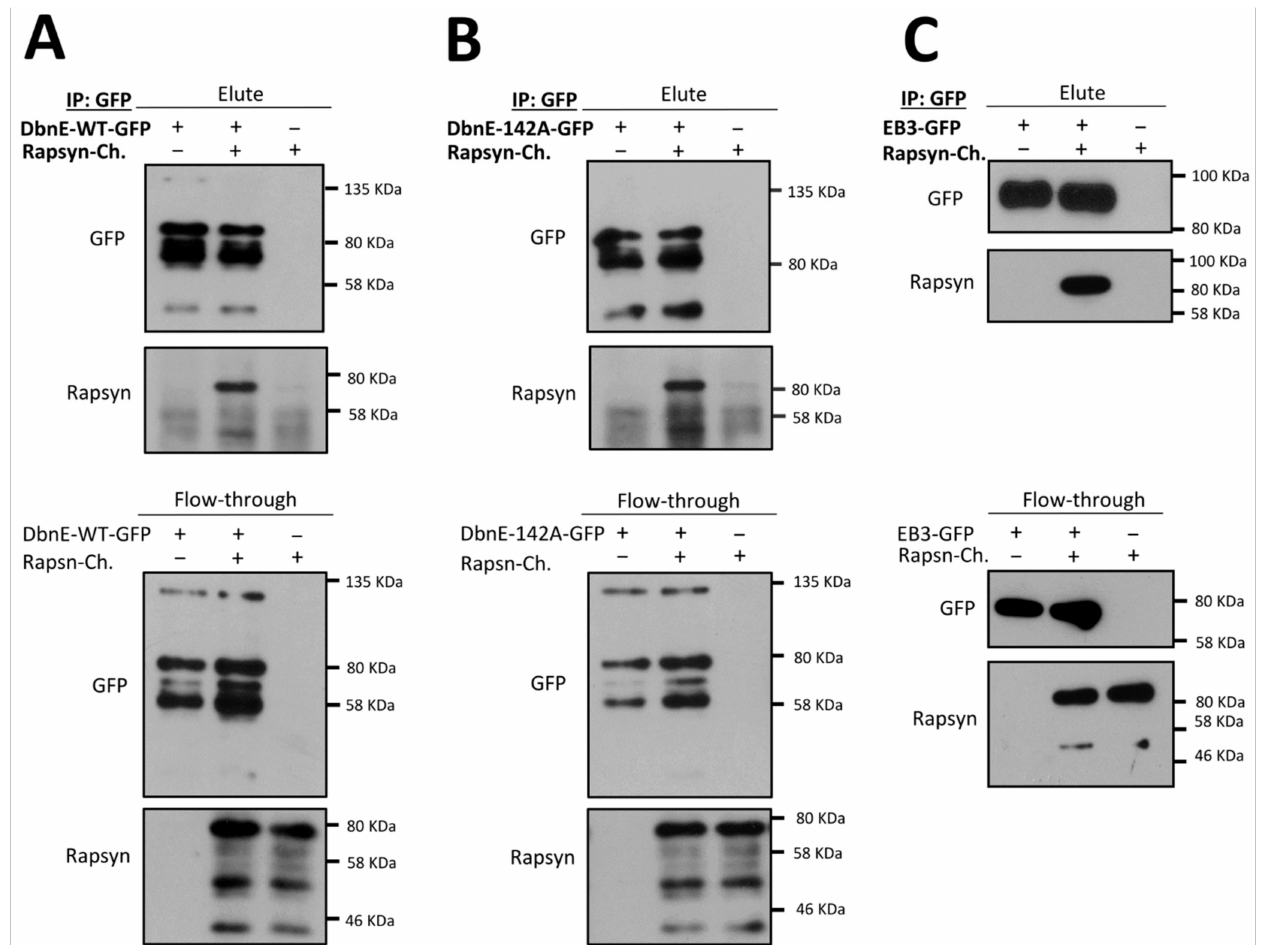
Figure 8. AChR-clustering regulator rapsyn interacts with drebrin. ( A ) Coimmunoprecipitation of overexpressed wild-type drebrin (DbnE-WT-GFP) with rapsyn (Rapsyn-mCherry) in HEK293 cells. ( B ) Coimmunoprecipitation of overexpressed phospho-dead drebrin mutant at Ser142 (DbnE-142A-GFP) with rapsyn (Rapsyn-mCherry) in HEK293 cells. ( C ) Coimmuno- precipitation of overexpressed EB3-GFP with rapsyn (Rapsyn-mCherry) in HEK293 cells. Elute—eluates from the beads incubated with equal volumes of lysates, Flow-through (FT)—lysates incubated with the